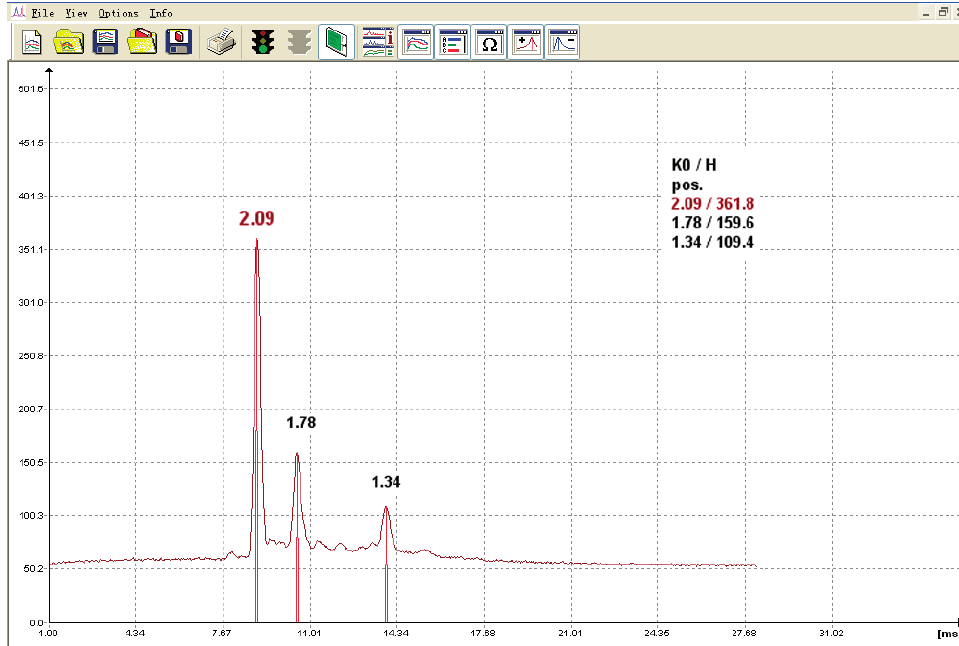
Figure 3. The typical spectra for each CWA obtained though SPME-IMS in water analysis.